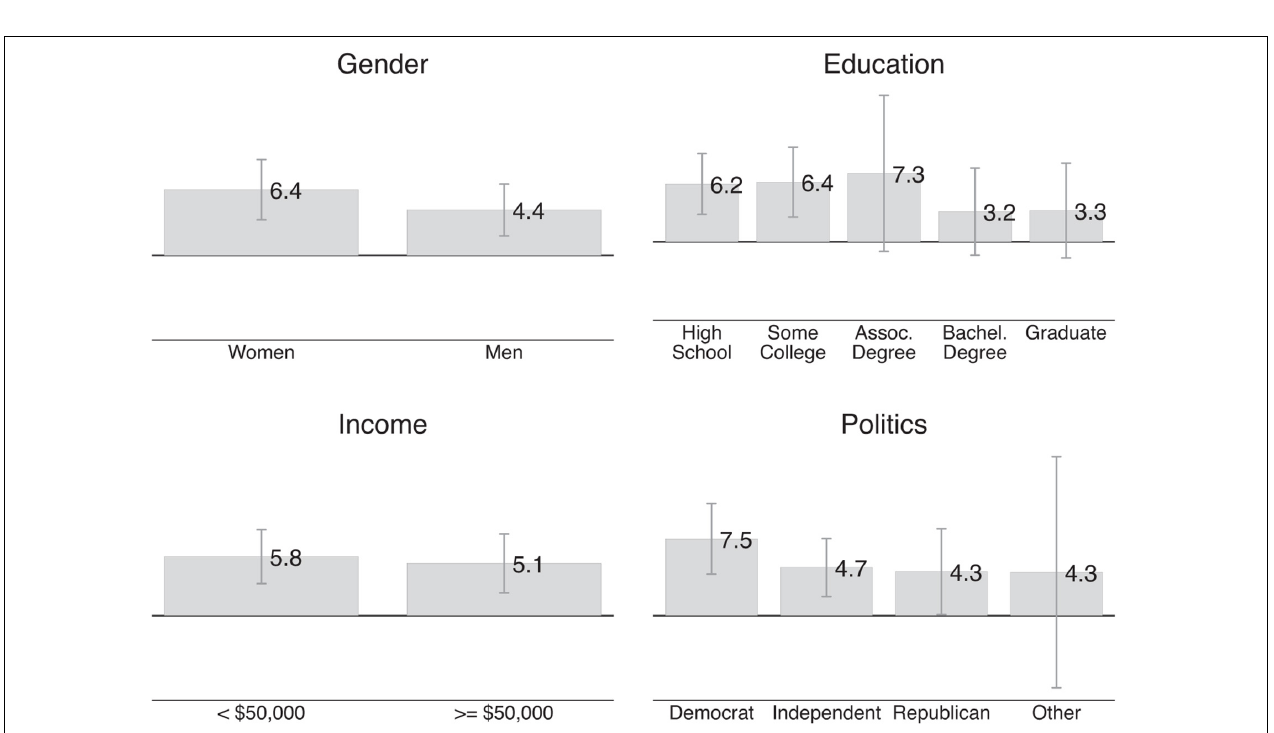
FIGURE 4 | Demographic predictors of pro-women attitude. This figure shows the average pro-women attitude for different groups in our Qualtrics sample. The pro-women attitude of each respondent is the moral judgment about a manager who discriminates against a woman (on a –50 to +50 scale where higher values indicate more disapproval) minus the moral judgment about a manager who discriminates against a man. Positive values mean that respondents judge discrimination against a woman as more morally bad.